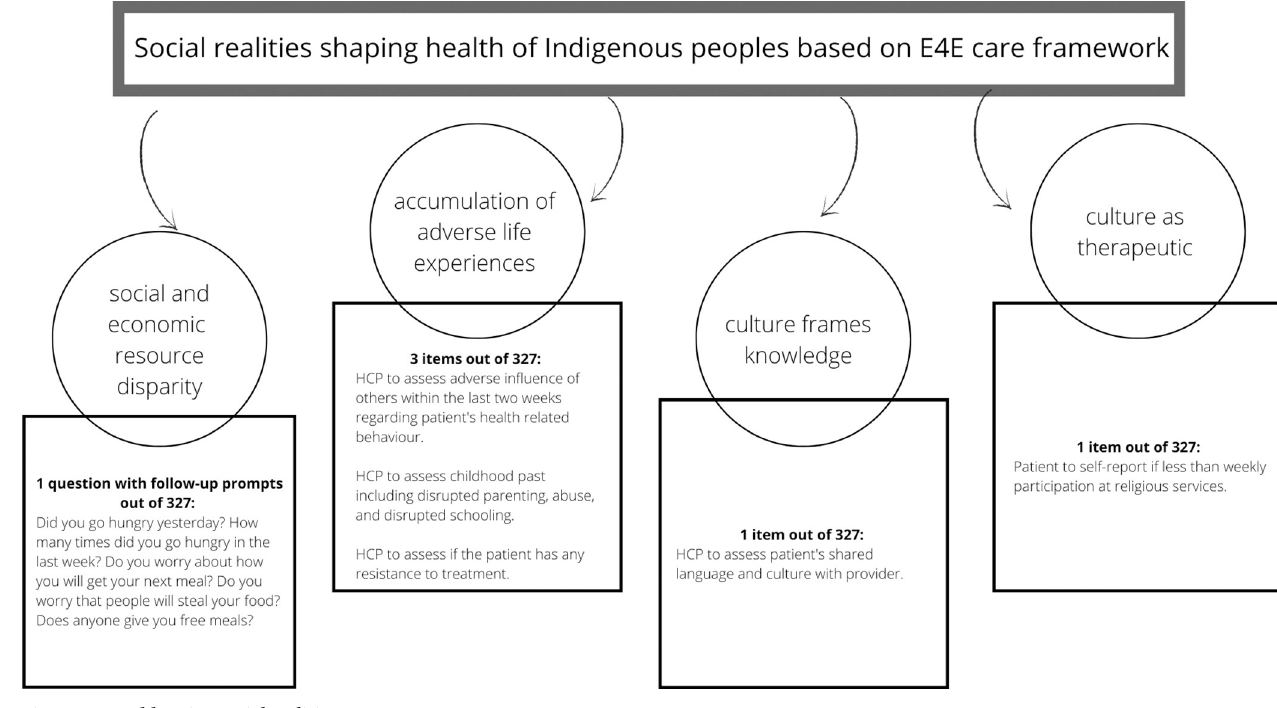
Fig 2. Items addressing social